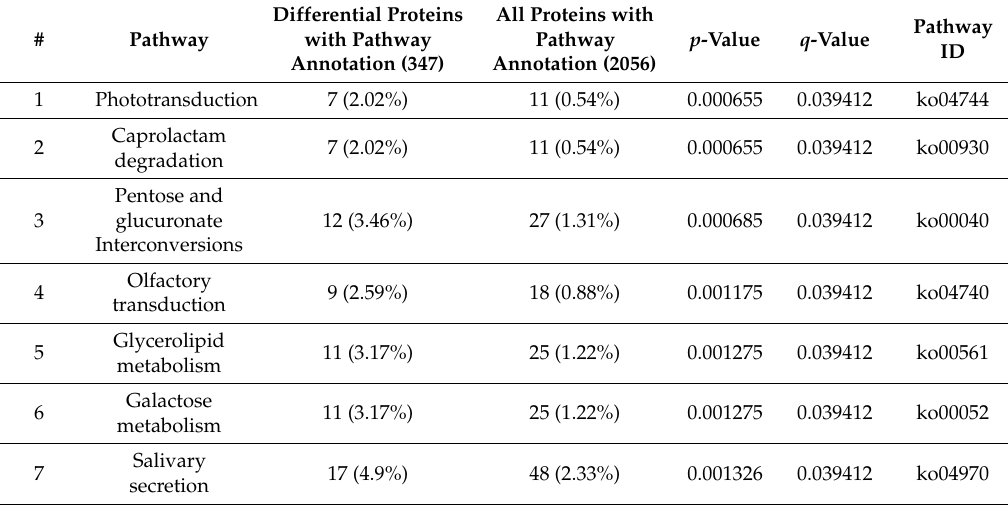
Table 3. Seven enriched pathways identified with KEGG analysis of differentially expressed proteins.